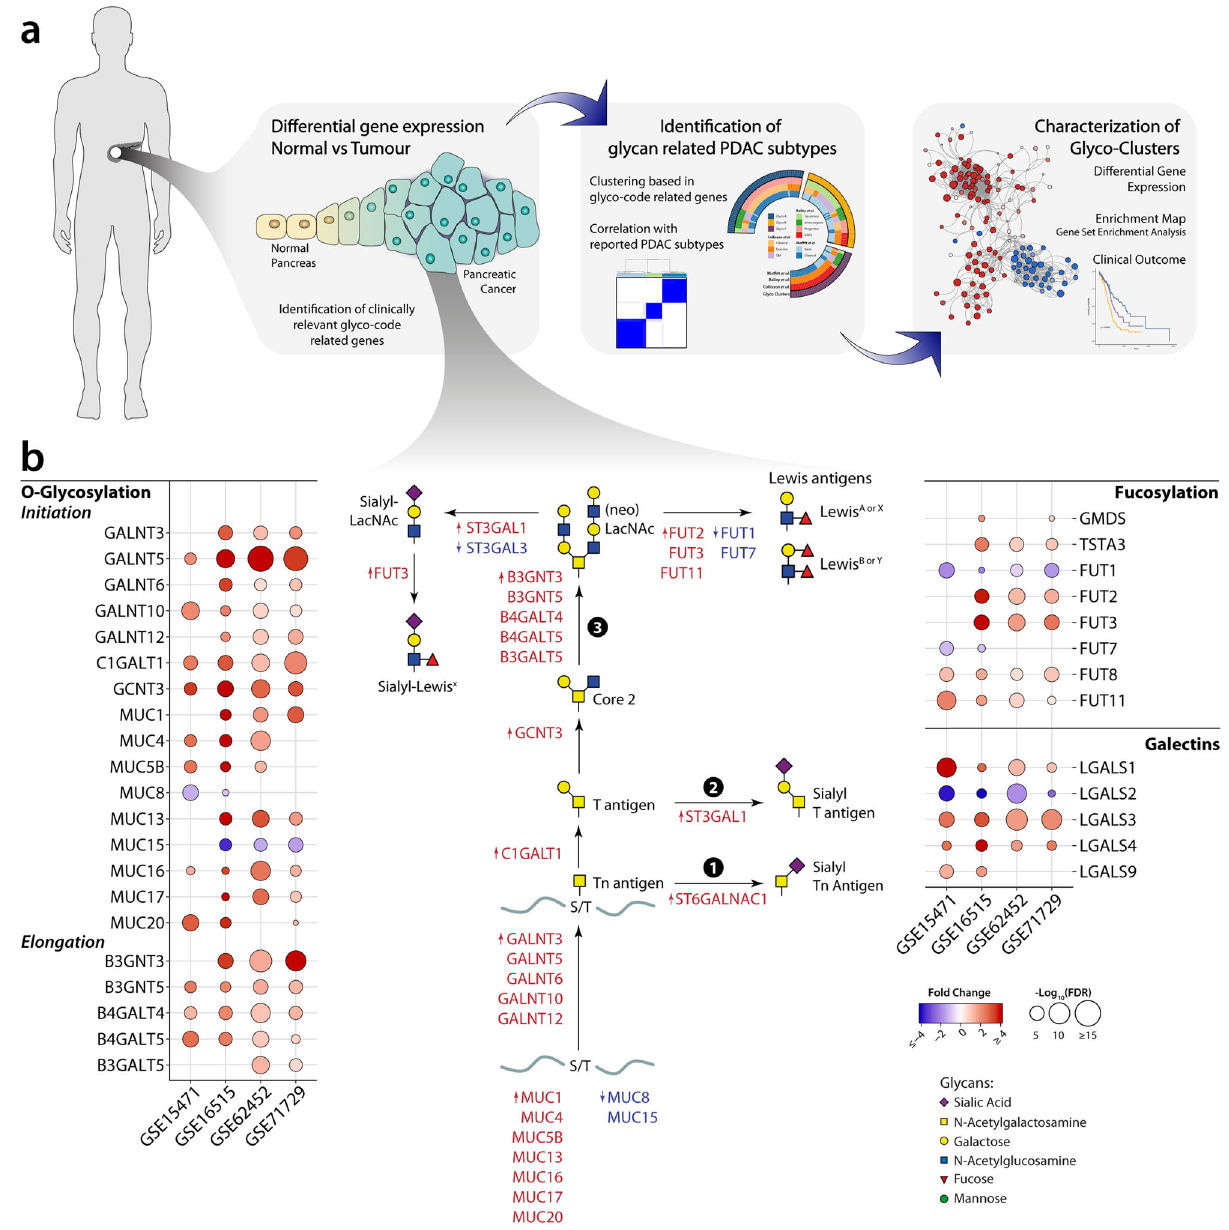
Fig. 1 Transcriptional changes in glyco-code related genes in pancreatic cancer. a Diagram of the steps used in this paper for the analysis of the role of the glyco-code in pancreatic cancer. b Analysis of glyco-code related genes differentially expressed in tumour tissue with respect to their normal counterpart showed fundamental changes in pancreatic cancer. Bubble plot representing the differentially expressed glyco-code related genes (rows) y four different datasets. Colour of the circles is associated with the fold change of tumour vs normal: red shows genes upregulated in tumour samples, while blue in normal samples. The size of the circles is associated with the p value, calculated as − log 10 ( p